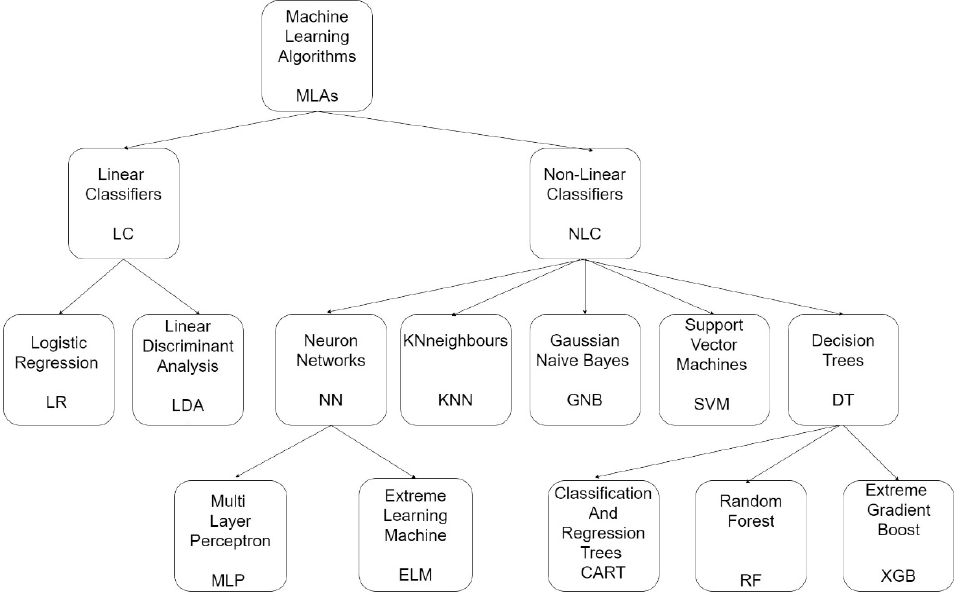
Figure 3. Outline of the Machine Learning Algorithms used.